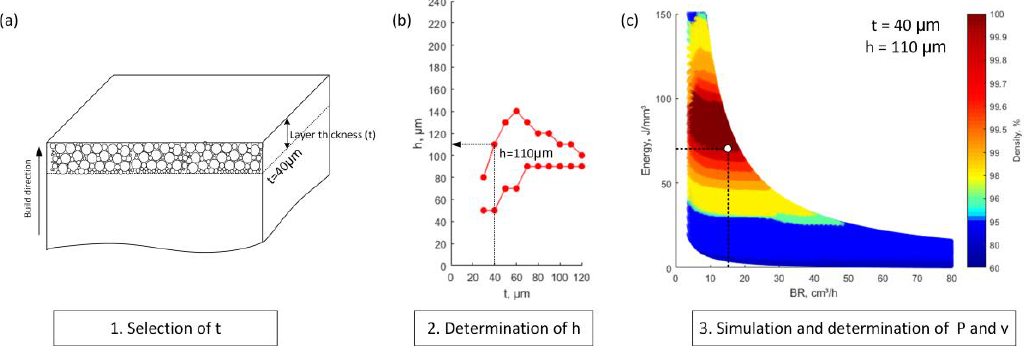
Figure 9. Steps needed for the printing parameters determination from a processing map: ( a ) selection of a layer thickness, ( b ) selection of an appropriate hatching space, and ( c ) determination of the corresponding laser power and scanning speed values.